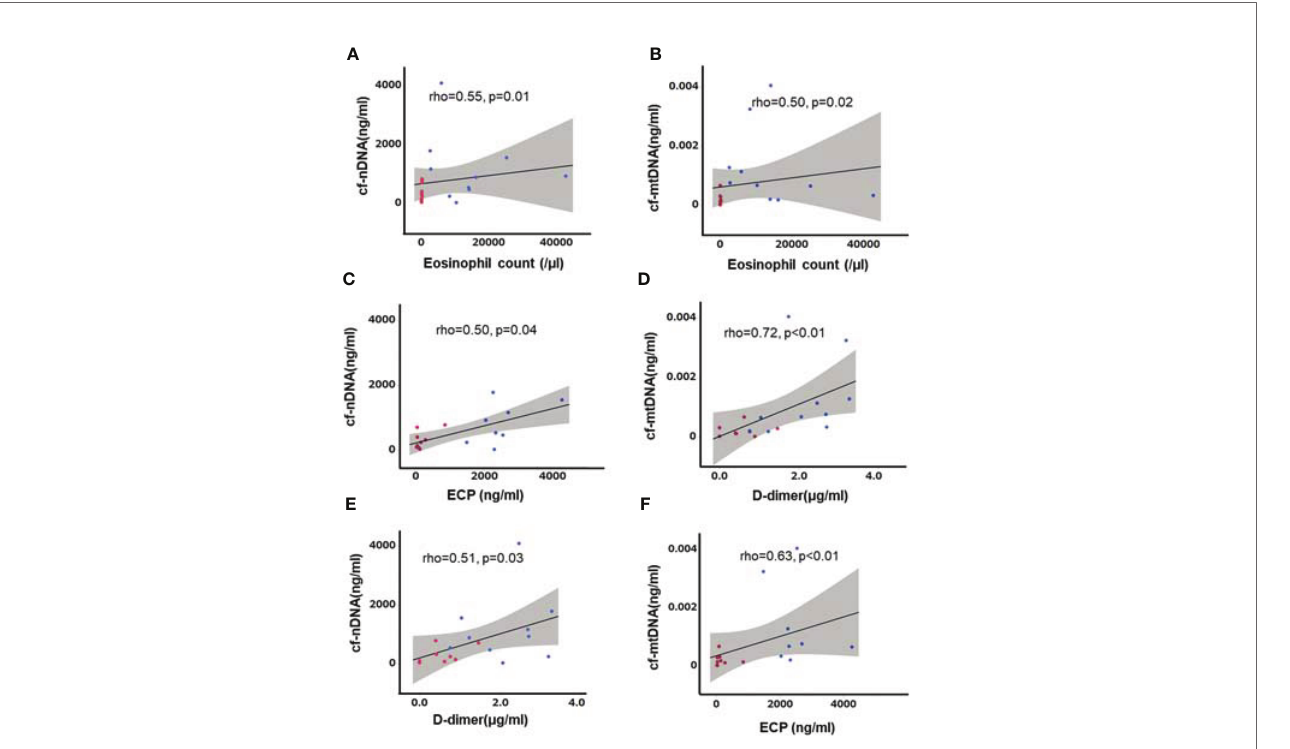
FIGURE 3 | Correlations between cfDNA and eosinophil count, ECP, and D-dimer level in patients with EGPA. Eosinophil count (A, B) ECP (C, D) , and D-dimer level (E, F) were associated with cf-nDNA and cf-mtDNA. Blue dots: before treatment, red dots: after treatment, straight line: regression line, gray area: 95% con fi dence interval, n=10, Spearman ’ s rank correlation coef fi cient.